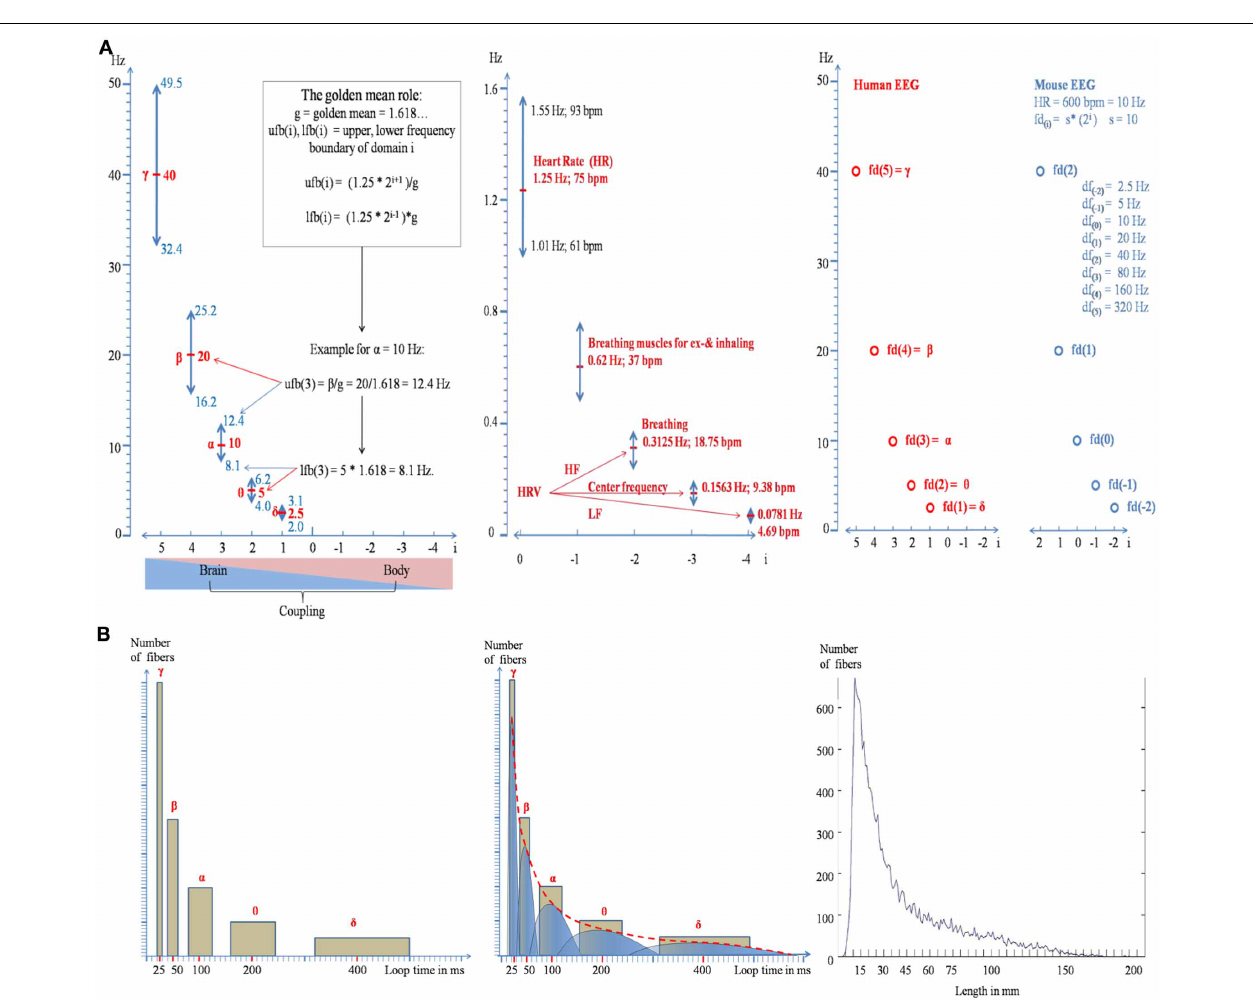
shown in the right panel. Note that the values for the center frequencies are the same as for humans but the relation to the index of a domain is changed. (B) Formula (2) can be used to predict the distribution of long-range white matter connectivity. The areas of the yellow rectangles in the left and middle panel represent the percentage of bundles for a frequency domain. Note that the area of each rectangle is constant and that the two sides of the rectangles change according to the doubling-halving algorithm of formula (2). The empirical distribution is shown in the right panel (data are from Hagmann et al. (2008), provided by Olaf